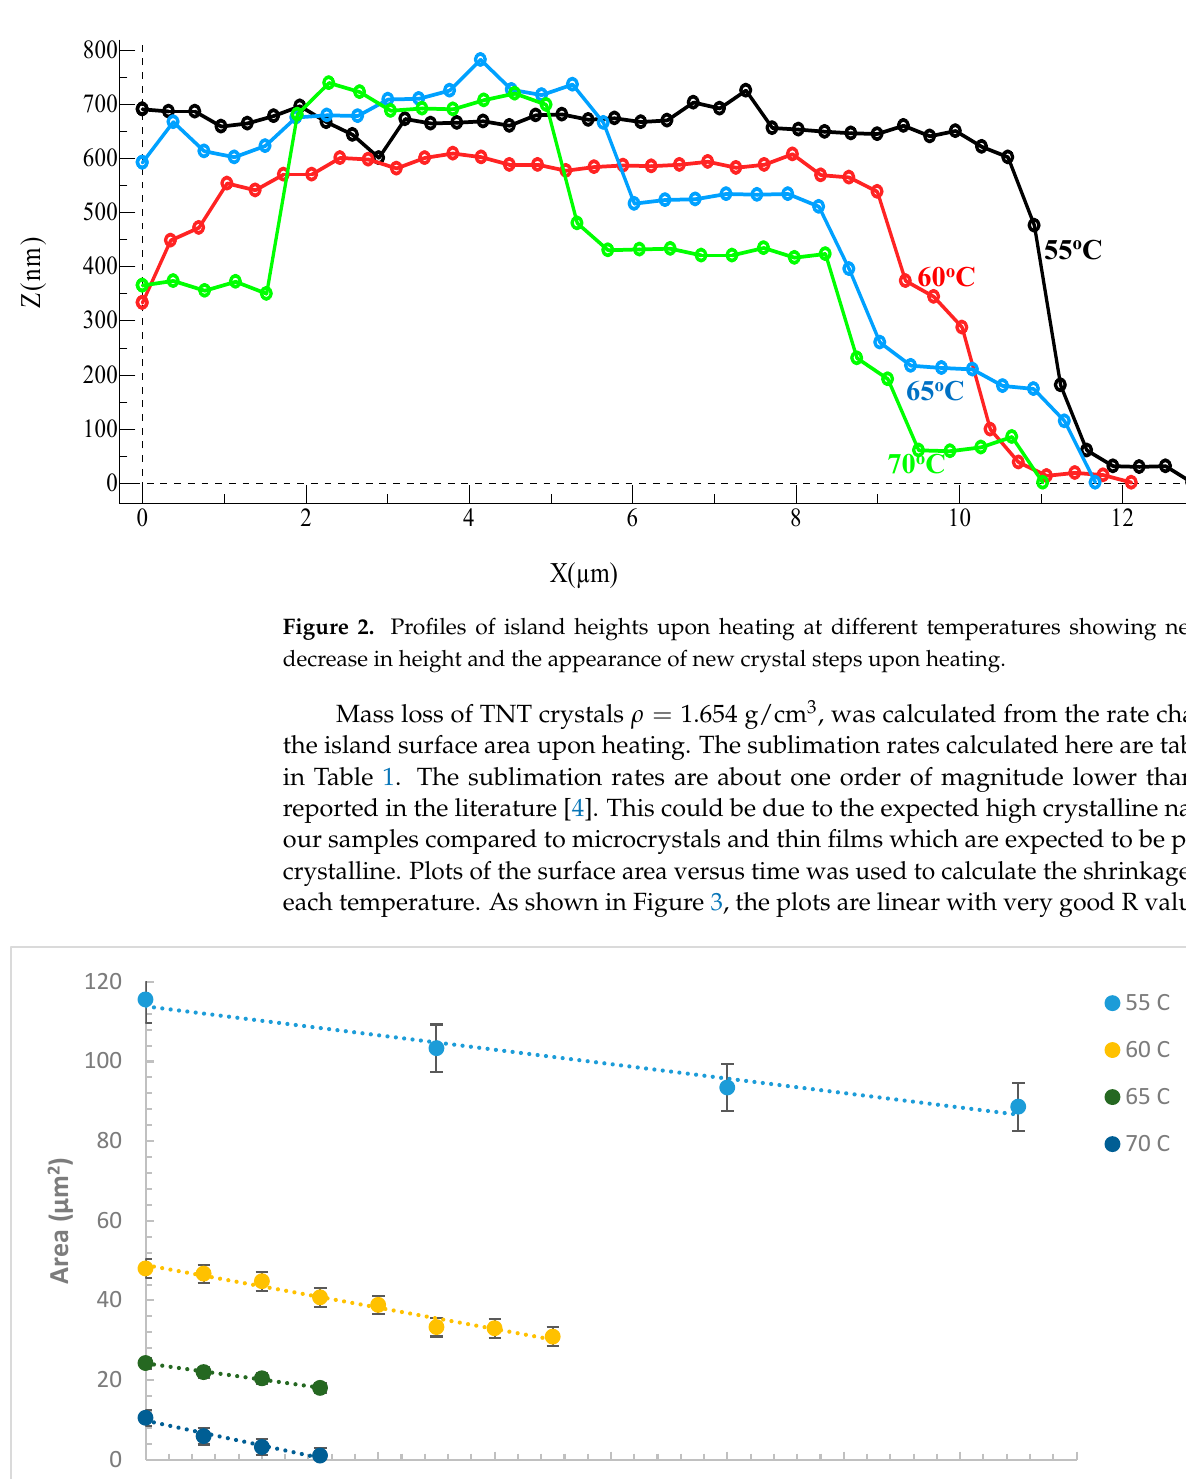
Figure 3. A plot of the surface area of the island vs time at different temperatures from which the shrinkage rates are calculated.